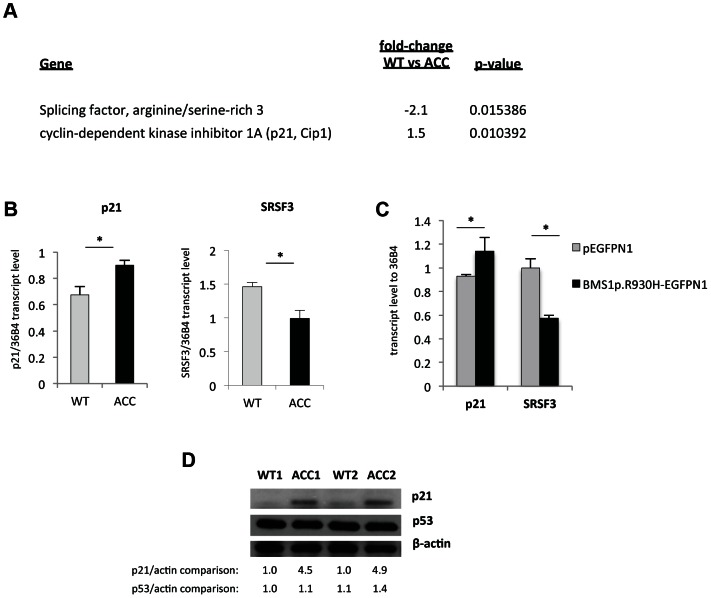
An increase in p21 levels in ACC skin fibroblasts.a. Microarray gene expression profiling experiments (experimental triplicates for ACC vs control fibroblasts) show an upregulation of p21 mRNA levels and a downregulation of SRSF3 mRNA levels in ACC fibroblasts. b. These findings were confirmed by semiquantitative RT-PCR. *P-values<0.05. c. Overexpression of mutant BMS1p.R930H in wild-type fibroblasts phenocopies ACC fibroblasts in showing increased p21 and decreased SRSF3 transcript levels. *P-values<0.05. d. Western blotting experiments show increased p21 protein levels in ACC fibroblasts compared to control fibroblasts, while p53 protein levels are not significantly changed. Relative values for bands normalized to loading control are shown.